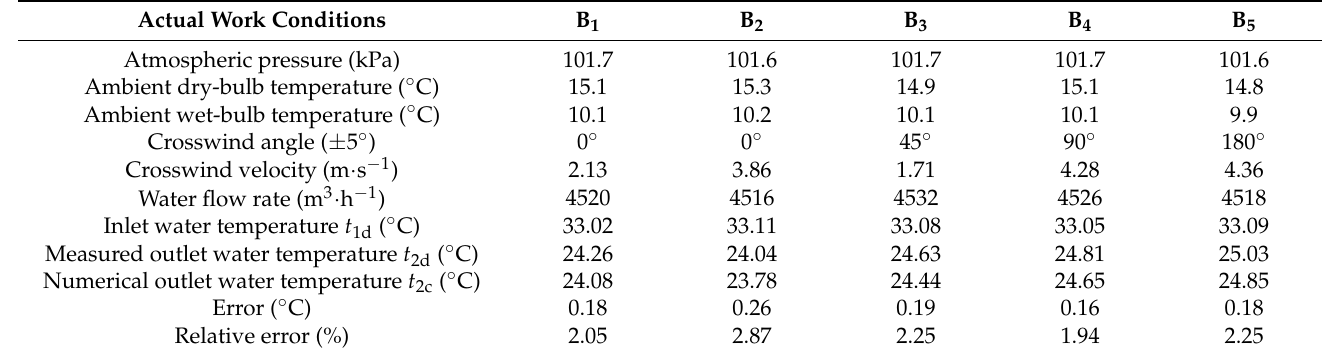
Table 3. Model validation according to measuring